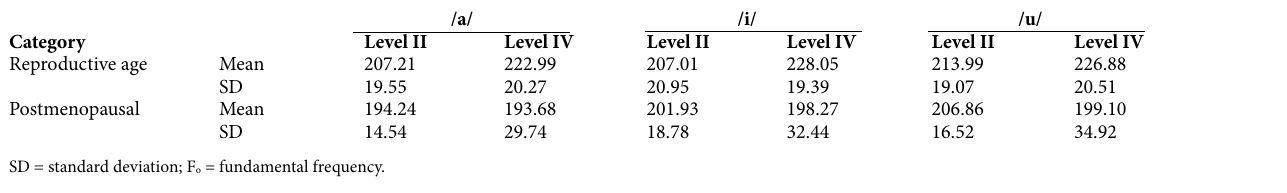
Table II. Means and SDs of F values (in Hz) for sustained phonation across the different groups of level II and o level IV professionals